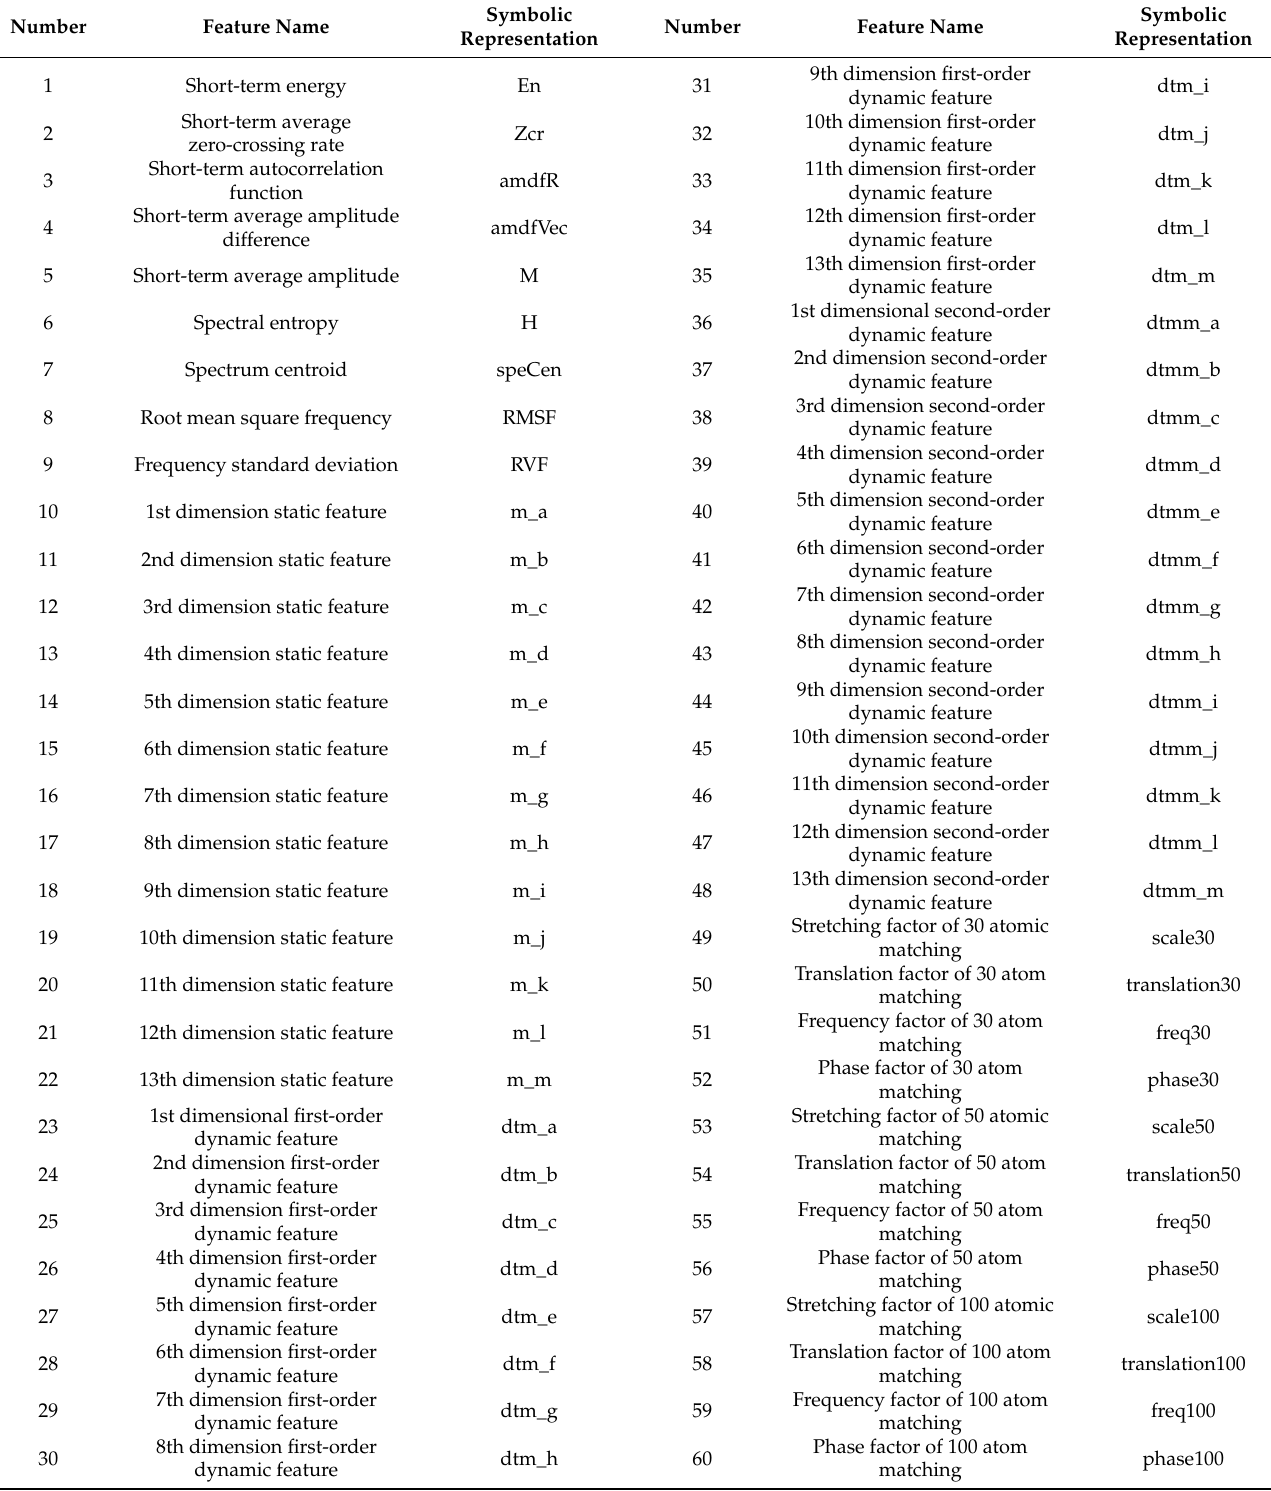
Table 1. Specific description of the extracted 60-dimensional classification